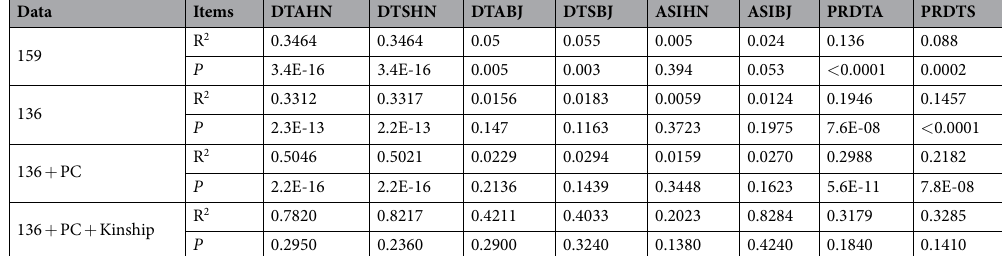
Table 2. R 2 (contribution coefficient) and P for each contribution coefficient determined from a linear model of genome size. Contribution coefficients for different indicators of flowering time for 159 tropical and temperate maize inbred lines in different zones are shown. A total of 136 out of 159 was fit to a linear model with population structure introduced and further with kinship introduced. DTS: days to silking; DTA: days to anthesis; ASI: anthesis-silk interval; PRDTA: photoperiod response of day to anthesis; PRDTS: photoperiod response of day to silking; HN: Hainan, represents tropical region; BJ: Beijing, represents temperate region.